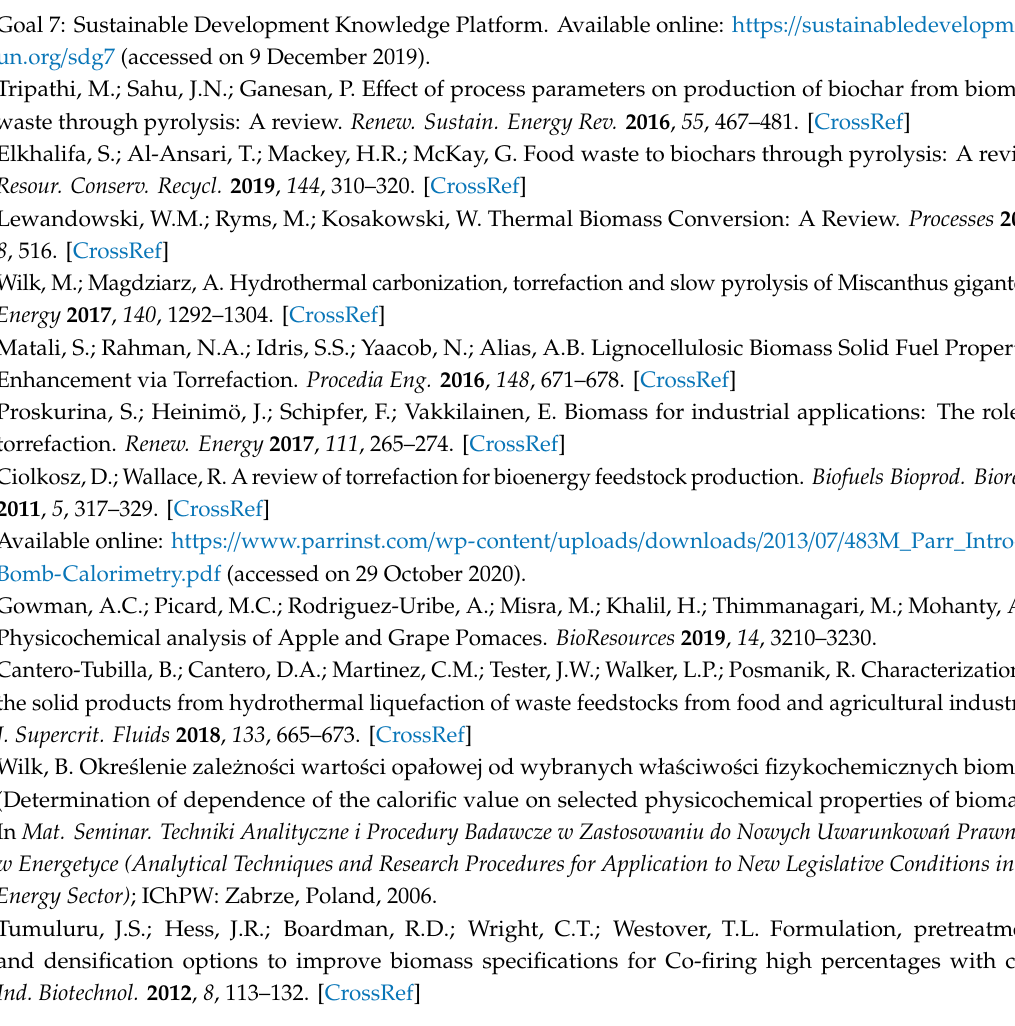
Figure S1: Photograph of the condensable gases—liquid products collected after pyrolysis of agricultural waste biomass. FSW—flavored spirits production waste (lime, grapefruit and lemon); B.pulp—beetroot pulp; A.pomace—Applepomace; BSG—brewer’s spent grain; bark; MSW—municipal solid waste., Figure S2: GC–MS separation of organic compounds extracted to chloroform from the condensates obtained by carbonization of biomass. FSW—flavored spirits production waste (lime, grapefruit and lemon); B.pulp—beetroot pulp; A.pomace—Apple pomace; BSG—brewer’s spent grain; bark; MSW—municipal solid